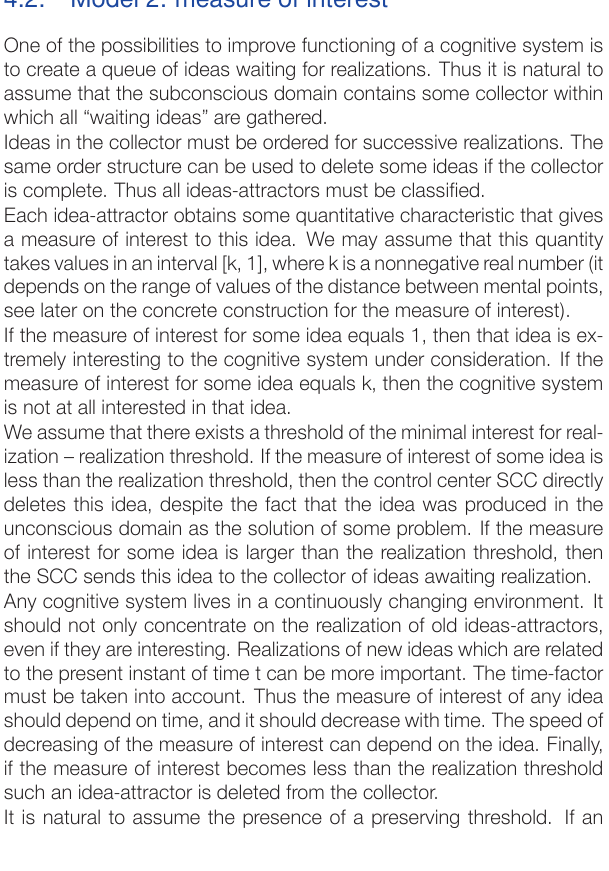
Figure 1: Besides the unconscious control center UC and the process- ing domain, the unconscious domain contains some other structures (empty boxes of this picture). These additional structures (in the sub- conscious as well as unconscious domains) will be introduced in more complex models. We shall also describe the character of connections between SCC and